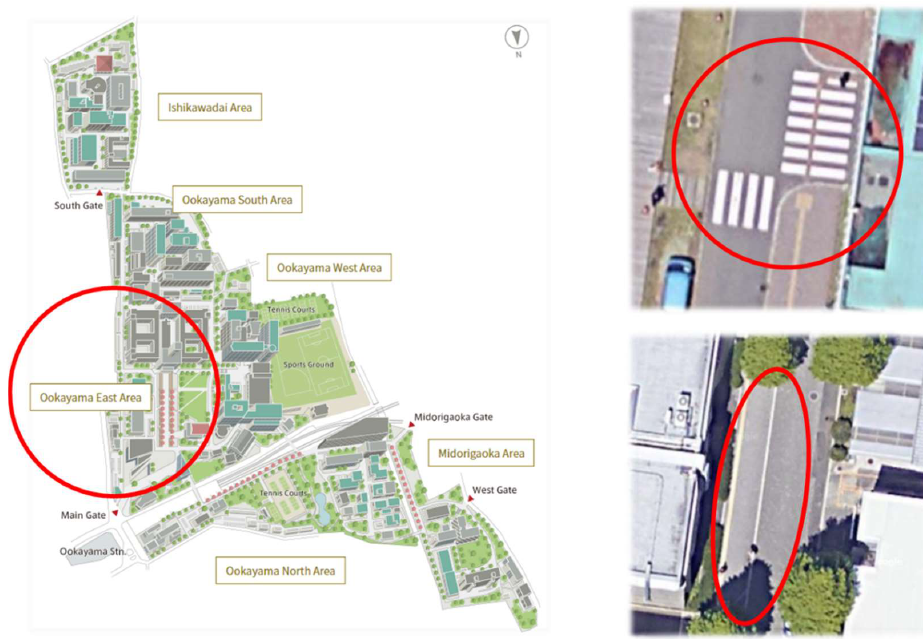
Figure 3. Encircled in red are the scanning location ( left ) taken from the Tokyo Tech website and road marking types visible in the area ( right ) taken from Google Earth.